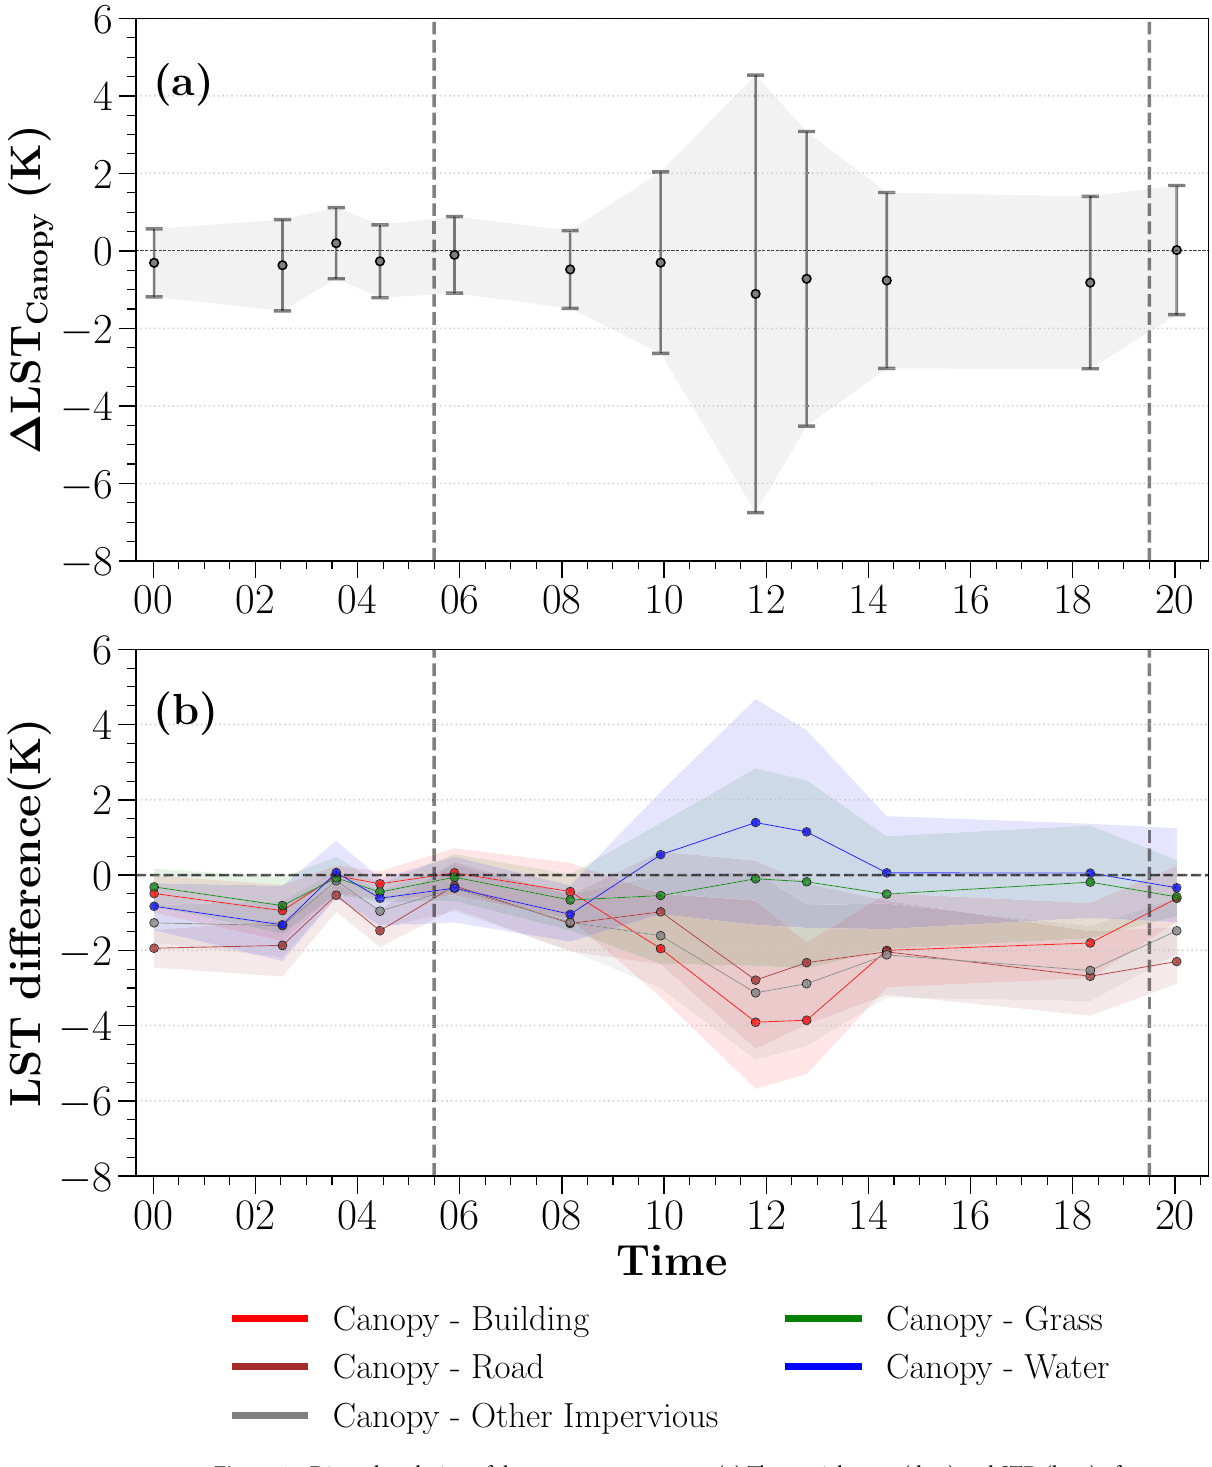
Figure 1. Diurnal evolution of the canopy temperature. ( a ) The spatial mean (dots) and STD (bars) of (cid:31) LST Canopy summarized at the city scale, ( b ) the mean and STD of temperature difference between tree canopies and other urban elements at the pixel level. Vertical dashed lines indicate the sunrise and sunset at the local